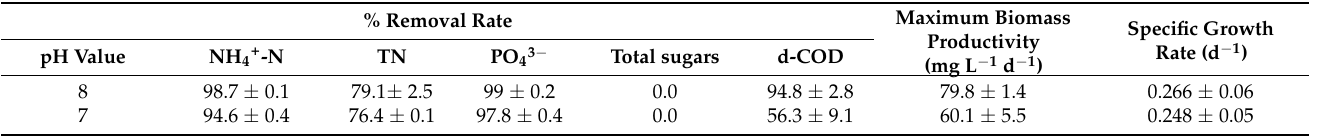
Table 5. Nutrient reduction rates, biomass productivity and specific growth rates achieved at pH 7 and 8.